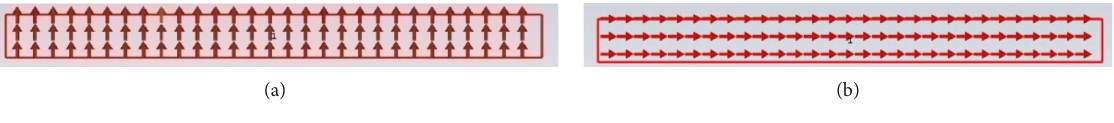
Figure 6: Port mode: (a) Electric field. (b) Magnetic